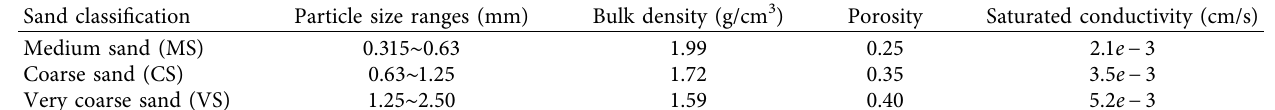
Table 1: Physical properties of sand with various ranges of particle size.